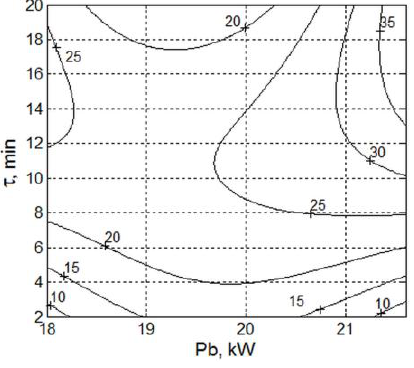
Figure 3. Contour plot of the material losses of the e-beam melting of Ta, where P b is the beam power and τ is the refining